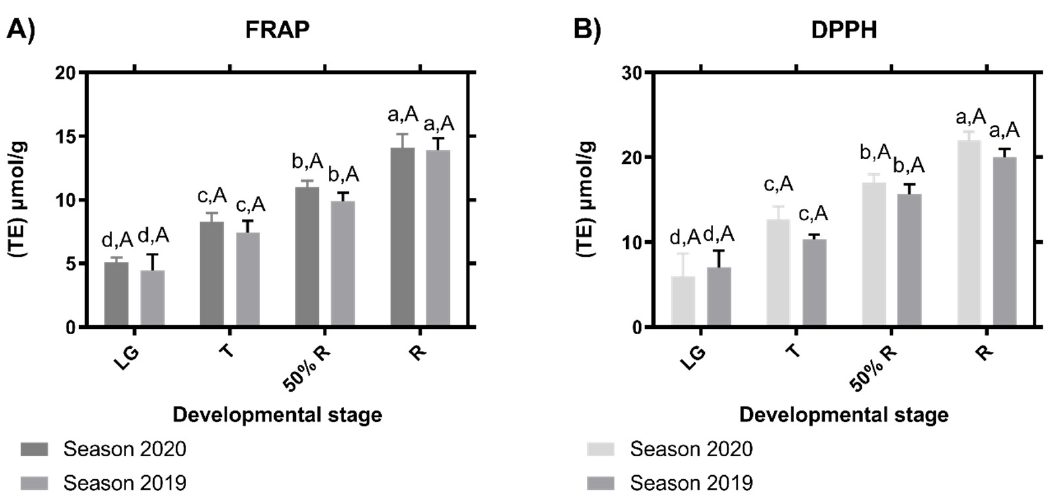
Figure 5. Antioxidant capacity of different blackberry ( Rubus ulmifolius Schott) fruit stages. Free radical scavenging activity by FRAP ( A ) and DPPH ( B ) was estimated. Data correspond to mean ± SE of three biological replicates. Different letters indicate significant differences between samples ( p ≤ 0.05; ANOVA). TE—Trolox equivalent. Table 3. Volatile compounds profile of blackberries at stages LG, 50%R, and R. Different letters in a row indicate statistical differences ( p < 0.05) among ripening stages for the same volatile compound group, according to the Tukey post-hoc test.